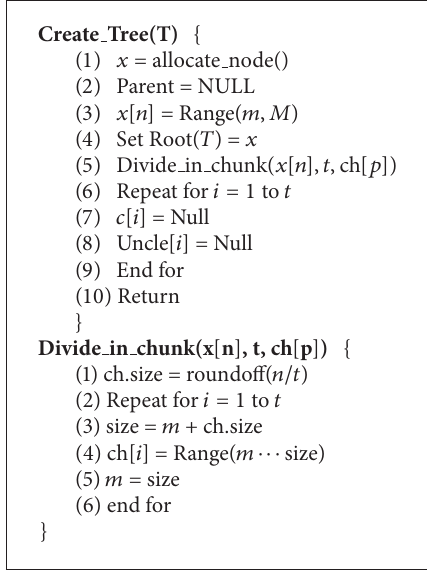
Algorithm 1: M-child family tree